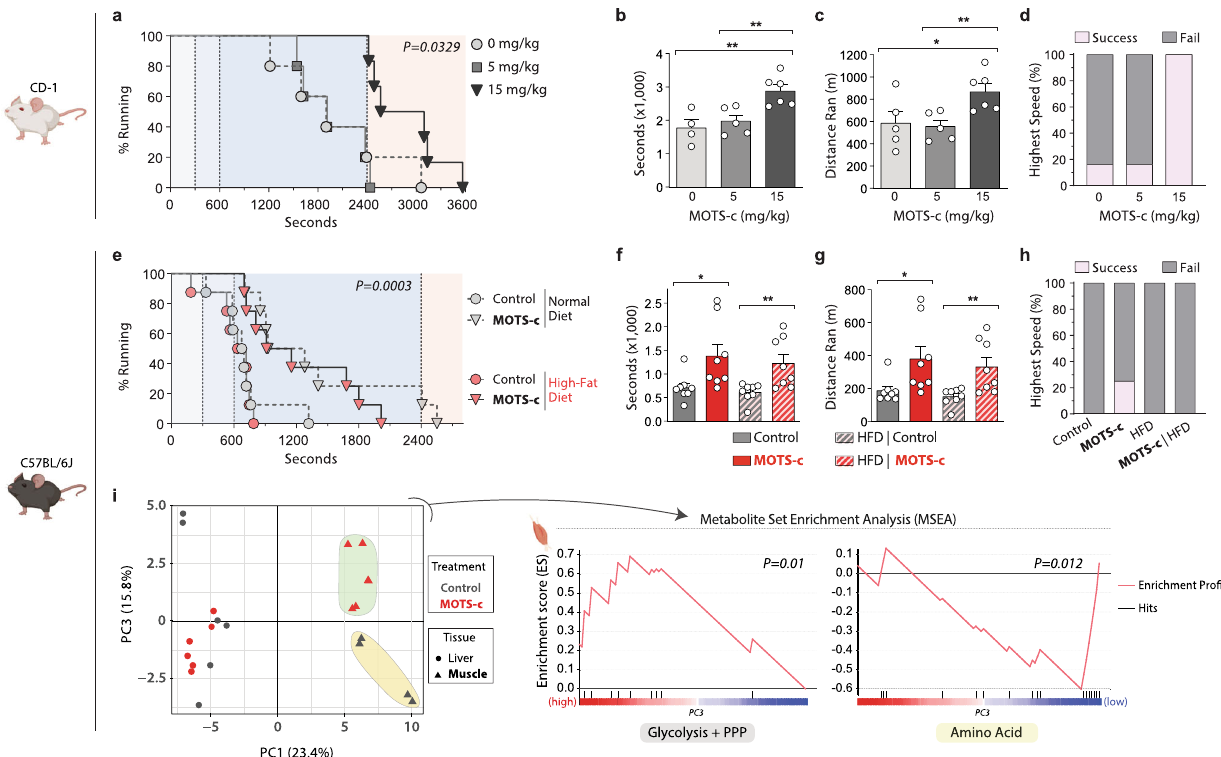
Fig. 2 MOTS-c treatment increases physical capacity in young mice regardless of diet. a – c Treadmill performance of 12-week-old male CD-1 (outbred) mice fed a normal diet ( n = 5, Control and 5 mg/kg MOTS-c; n = 6, 15 mg/kg MOTS-c); a running curves ( P = 0.0329), b total time on treadmill ( P = 0.0069, 0 vs. 15; P = 0.0081, 5 vs. 15), c total distance ran ( P = 0.0418, 0 vs. 15; P = 0.0081, 5 vs.15), and d percent capable of reaching the highest speed (sprint). e – h Treadmill performance of 12-week-old male C57BL/6J (inbred) mice fed a HFD ( n = 8); e running curves ( P = 0.0003), f total time on treadmill ( P = 0.0237, normal diet control vs. normal diet + MOTS-c; P = 0.0084, HFD control vs. HFD + MOTS-c) g total distance ran ( P = 0.0326, normal diet control vs. normal diet + MOTS-c; P = 0.0087, HFD Control vs. HFD + MOTS-c) h percent capable of reaching the highest speed ( fi nal stage). i PCA and MSEA on metabolomic data from skeletal muscle and liver of C57BL/6J mice that were fed a HFD, treated with MOTS-c, and exercised. Data expressed as mean ± SEM. Log-rank (Mantel-Cox) test was used for a , e . Otherwise, all statistics were performed using the two-sided Student ’ s t test. * P < 0.05, ** P < 0.01, *** P <